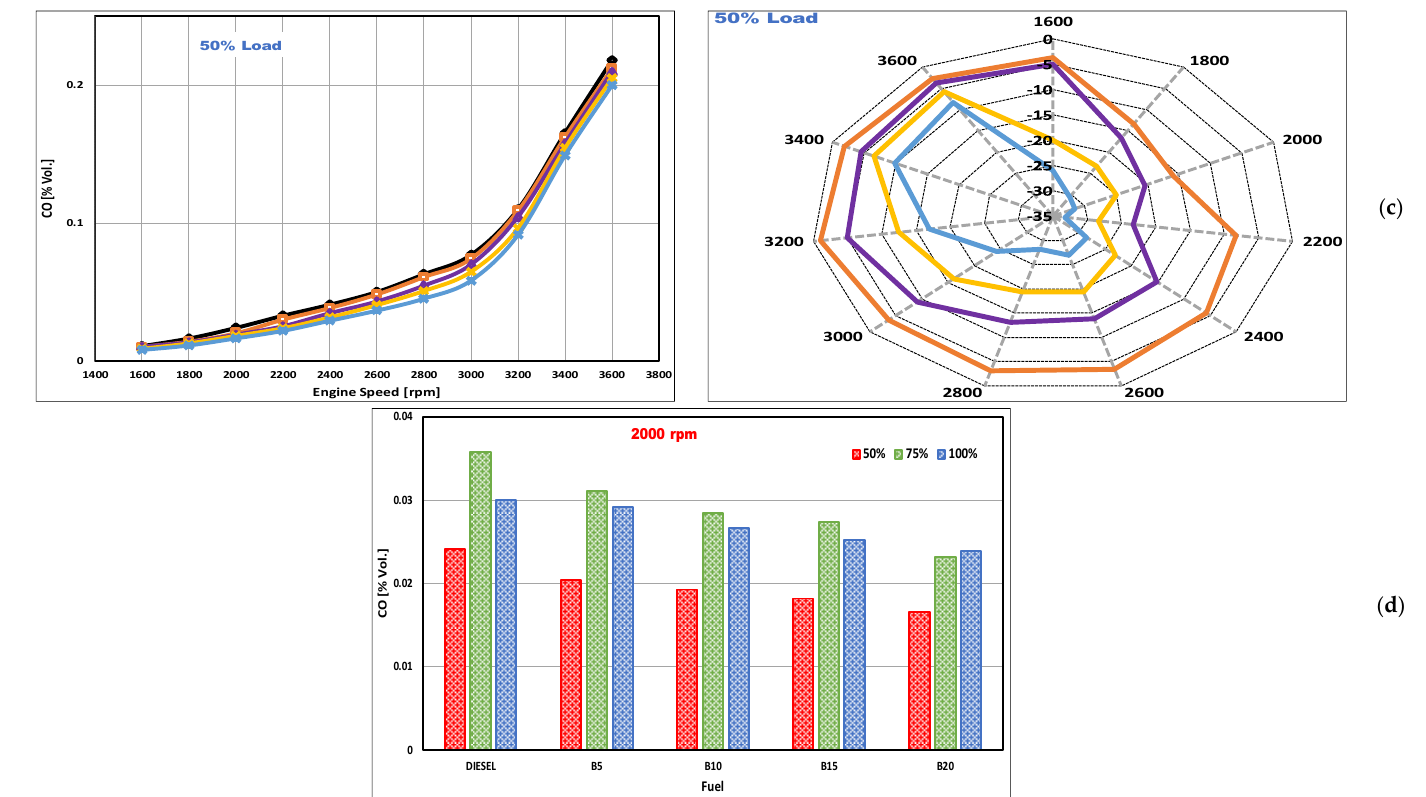
Figure 4. CO variations with engine speed and load, presented as trends (left) and the normalized value contours (right) for ( a ) 100%, ( b ) 75%, and ( c ) 50% loading. ( d ) Comparison of the results for all fuels at all loads at 2000 rpm.